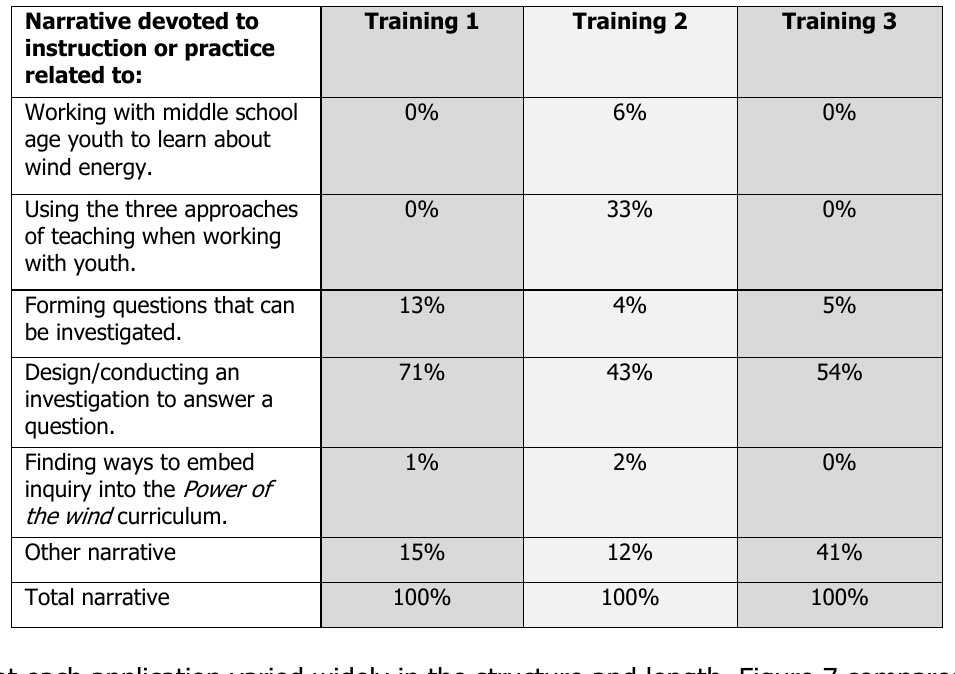
Narrative Use in Adult Facilitator